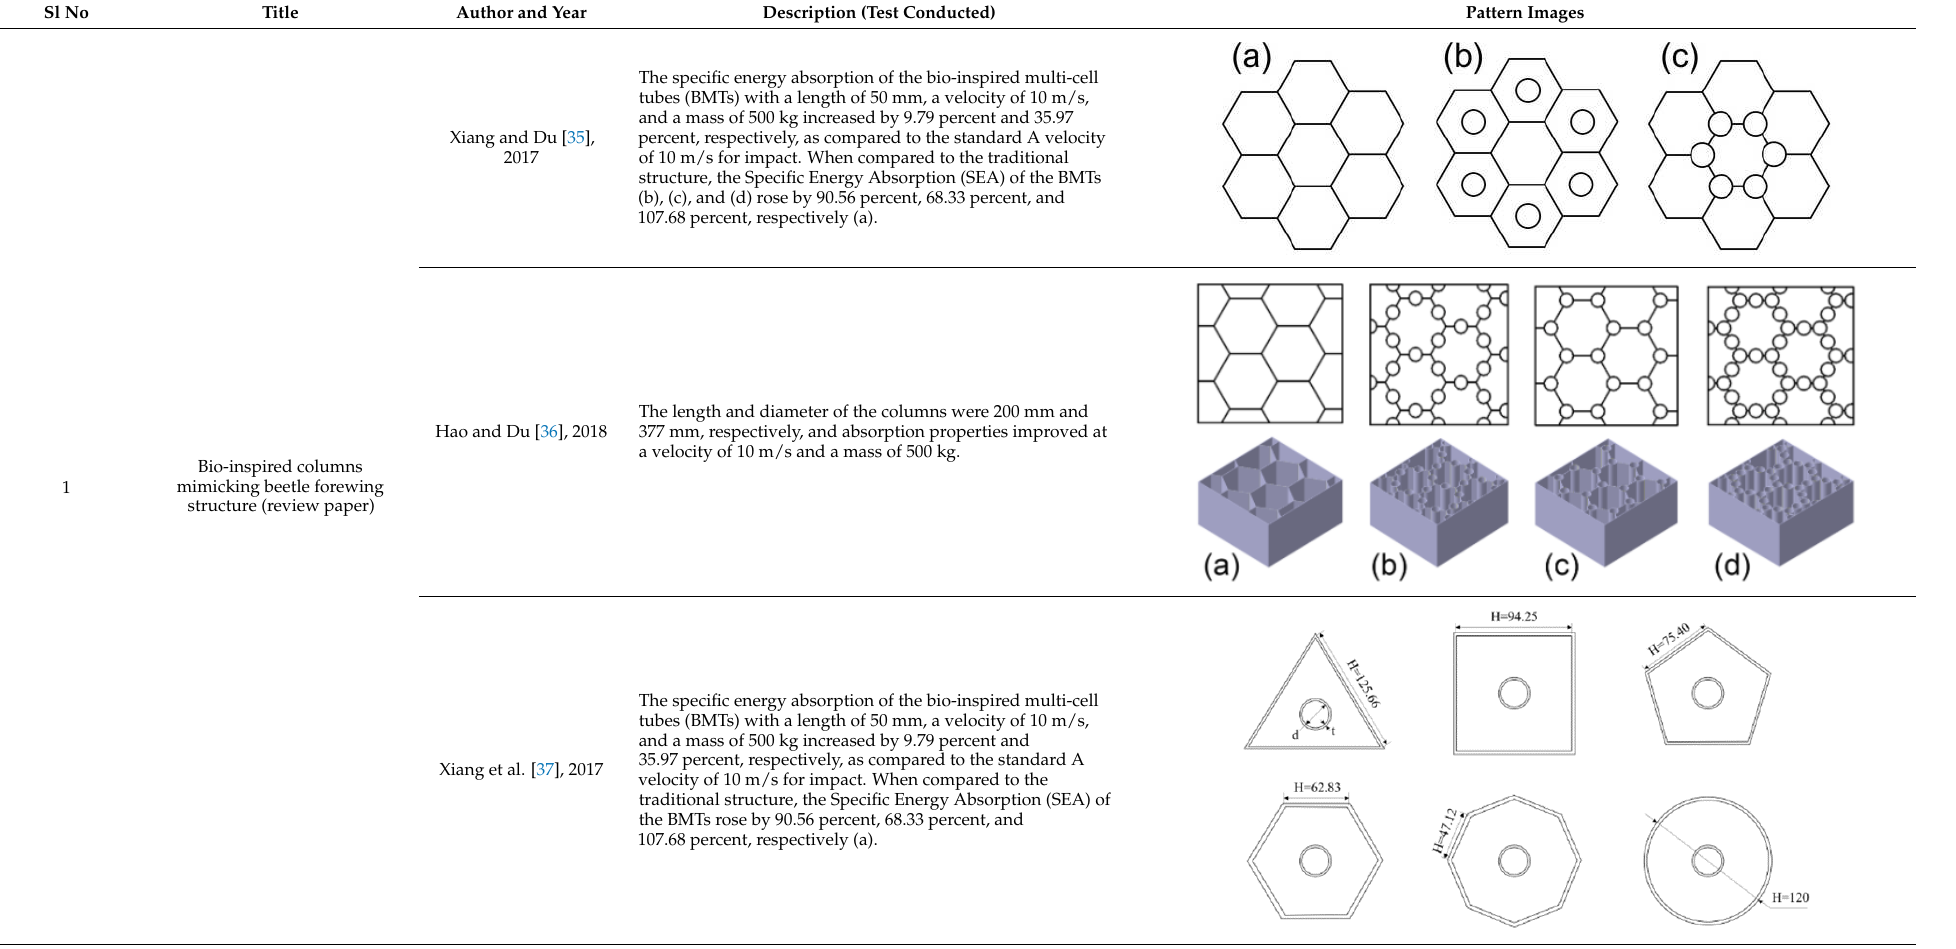
Table 1. Bio-inspired design models built by predecessor authors.